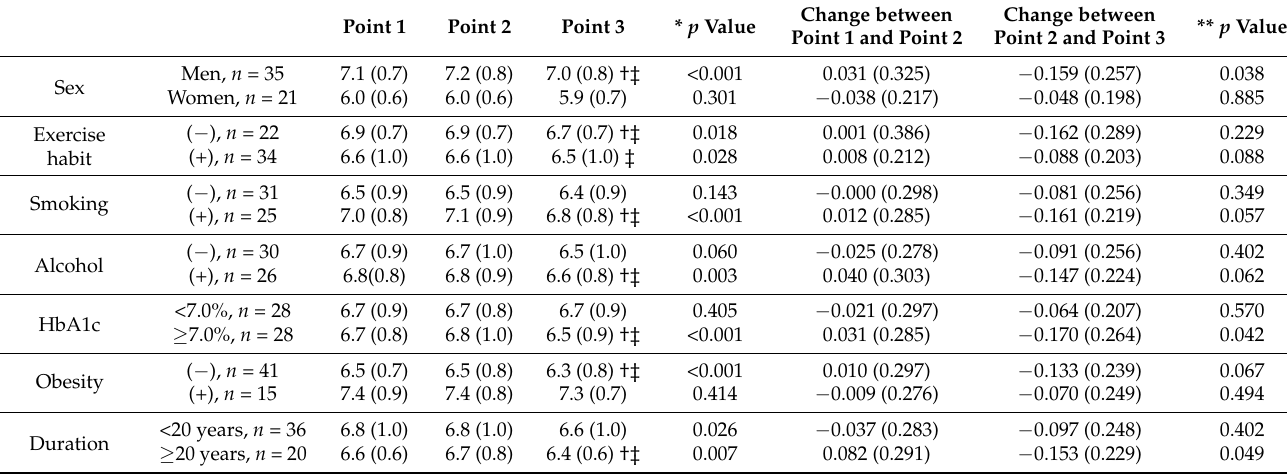
Table 3. Subgroup analysis of change in skeletal muscle mass index before and after the start of the COVID-19 pandemic.